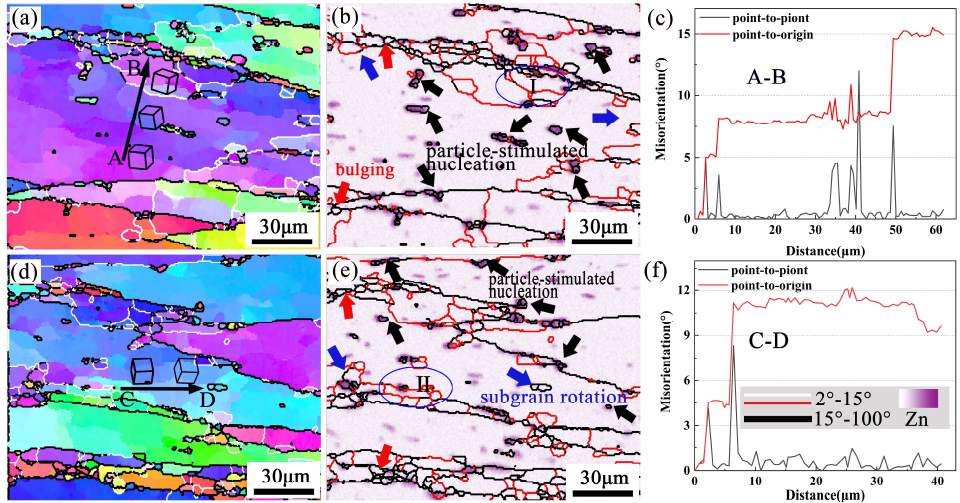
Figure 8. The typical region R1 ( a – c ) and R2 ( d – f ) selected in EBSD -EDS maps partially enlarged at 380 °C /0.001 s −1 . tangle of Figure 7. Figure 8b,e are the EDS maps of the Zn element. DRX occurs around the second phase particles which are rich in Zn, as indicated by the black arrows. Because of the strain gradient caused by second phase particles during deformation, the nucleation growth of small recrystallized grains is promoted, this belongs to DDRX [29]. Moreover, many fine recrystallized grains were distributed at the zigzag grain boundaries (as red arrows in Figure 8b,e). The grain boundaries were driven toward high-energy storage and generated new recrystallized nuclei because of the strain gradient between adjacent grains during compression. The black line A → B/C → D (Figure 8a,d) represents the misorienta- tion distribution from point to point along the arrow. The grain color changes on the line, indicating that the dislocation movement ability in this area is high. The point-to-point line was above 0° and the point-to-origin line exceeded 10° representing subgrain rotation (Figure 8c,f). Rotation of the crystal lattice leads to the LAGBs transform into HAGBs, thus forming new grains (as marked by blue arrows). It represents a typical CDRX occurrence [30]. Many subgrains are observed in the original grain, shown as Ⅰ and Ⅱ in Figure 8b,e.